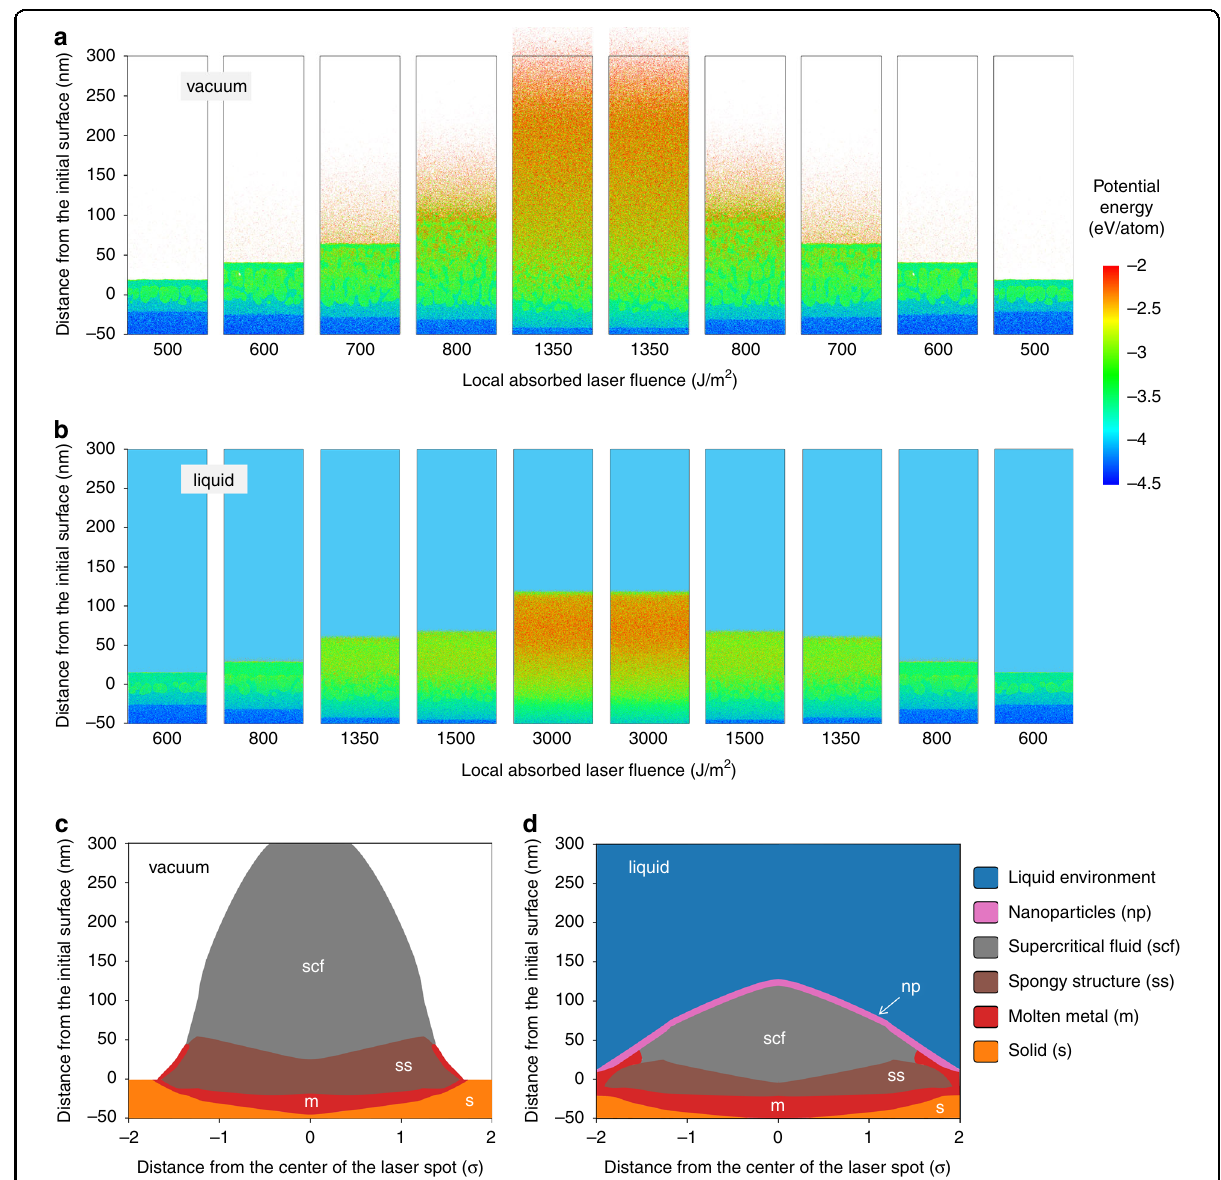
Fig. 1 The initial stage of laser ablation predicted in atomistic simulations. The results of large-scale atomistic simulations are shown for FeNi alloy targets irradiated by 10 ps laser pulses in vacuum ( a , c ) and in water ( b , d ). The snapshots from simulations performed at different values of local laser fl uence realized in different parts of a laser spot are shown in ( a , b ) for a time of 100 ps after the laser pulse. The atoms in the snapshots are colored by potential energy, with blue, green, and red colors corresponding to the solid, liquid, and vapor phases. The corresponding maps of the phase state of the material in different parts of the ablation plumes generated by laser beams with Gaussian spatial pro fi les with standard deviation σ and peak absorbed laser fl uences of 1500 J/m 2 and 3000 J/m 2 are shown in ( c ) and ( d ), respectively. The phase maps are based on the analysis of density and temperature distributions predicted in the atomistic simulations. Note that the images are shown with a large aspect ratio between the lateral and vertical dimensions to provide a clear view of distinct layers of the ablation plume, which remain essentially fl at at this early stage of the ablation